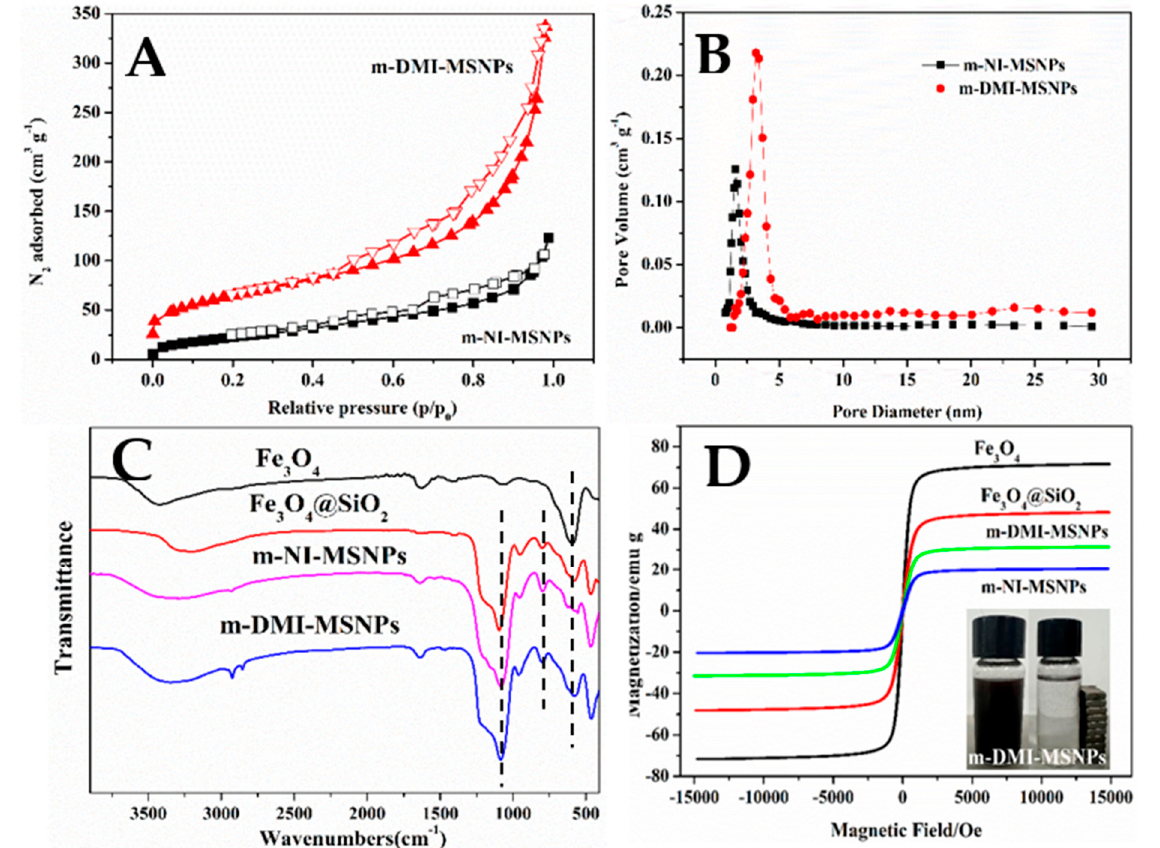
Figure 4. ( A ) N 2 sorption isotherm curve of m-NI-MSNPs and m-DMI-MSNPs, ( B ) BJH pore-size distribution of m-NI-MSNPs and m-DMI-MSNPs, ( C ) FT-IR spectra of Fe 3 O 4 , Fe 3 O4@SiO 2 , m-DMI- MSNPs, and m-NMI-MSNPs, and ( D ) VSM spectroscopy, inset: photographs of m-DMI-MSNPs sus- pended in BPA.